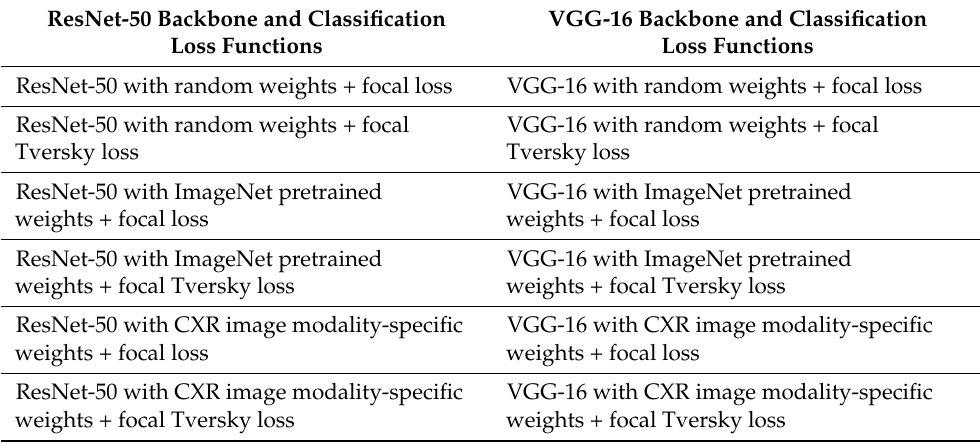
Table 2. RetinaNet model classifier backbones with varying weight initializations and loss functions. The loss functions mentioned are used for classification. For bounding box regression, only the smooth-L1 loss function [26] is used in all cases.